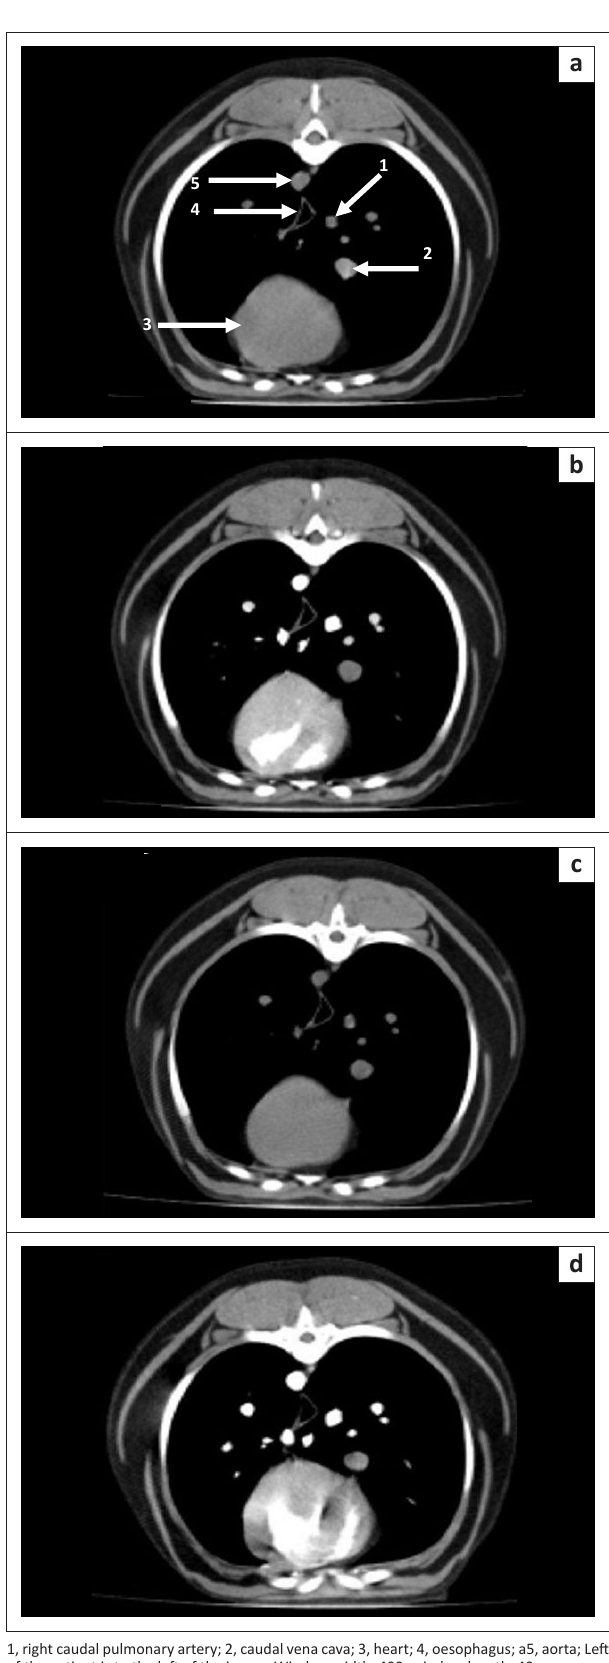
FIGURE 1: Transverse pre-contrast and post-contrast images of dog 2 at the level of T8. The image (a) pre-contrast image during the BT technique; (b) BT post- contrast arterial phase; (c) pre-contrast image during the TB technique and (d) TB post-contrast arterial phase.